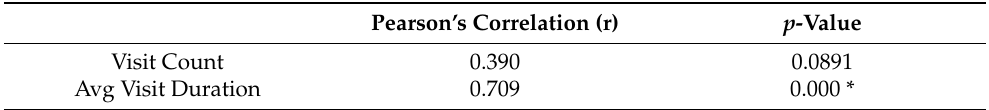
Table 9. Pearson’s correlation—search efficiency (average convex hull coverage) by pipefitter interac- tion (visit count, average visit duration).